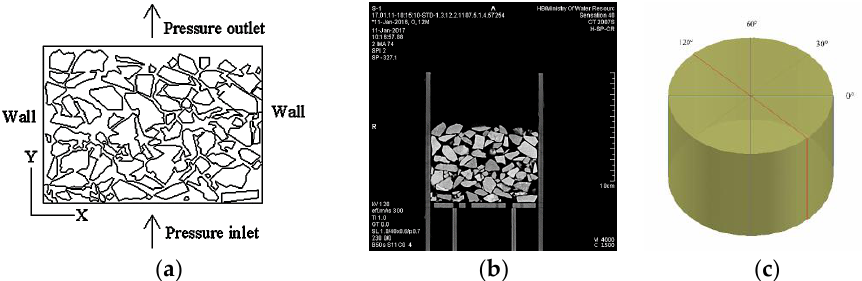
Figure 5. Numerical simulation model. ( a ) Schematic of the computational domain and the boundary. ( b ) The corresponding CT section of S1. ( c ) Schematic representation of the model’s cut location. The control equation of the simulation in the domain area Ω is given below [51].